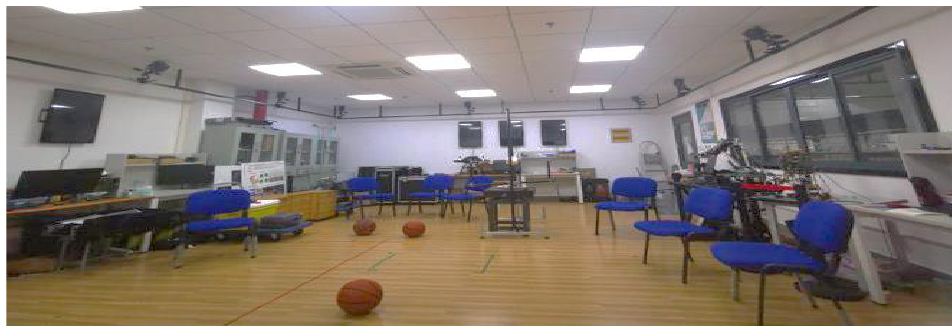
Figure 28. The 3D localization results of the cars and bikes in the outdoor test scene. Table 11. Localization error statistics in the outdoor test scene.